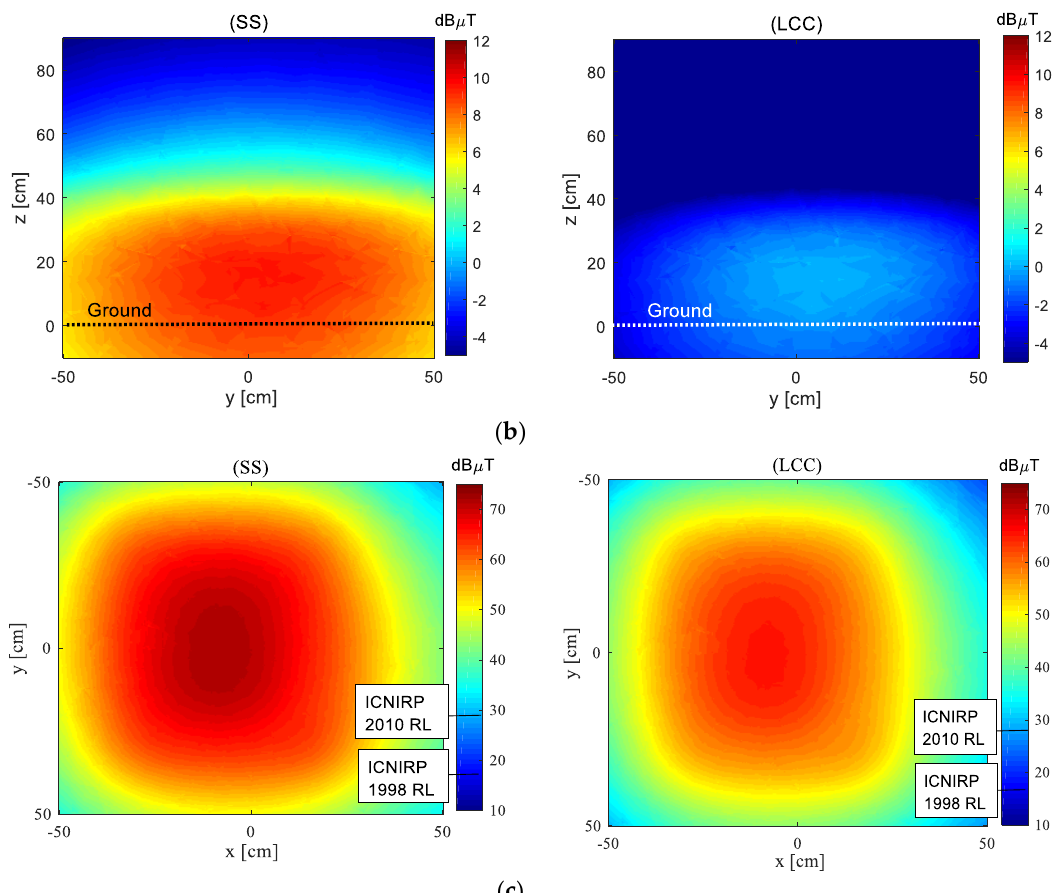
Figure 21. Maps of the magnetic flux density B (rms) on the planes p 1 ( a ), p 2 ( b ) and p 3 ( c ) for SS and LCC compensations.